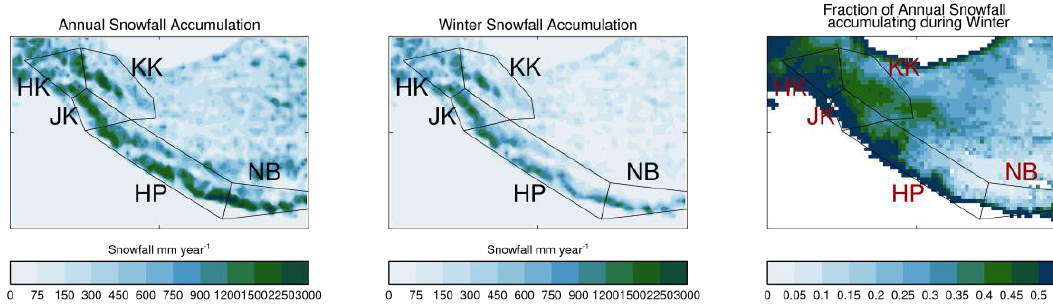
Figure 3. Annual snowfall accumulation along the Himalayan belt (left), winter snowfall (December to March) accumulation (centre) and the fraction of annual snowfall occurring during the winter. Data are 1992–2008 averages from ERA-Interim downscaled with the HadRM3 regional climate model.